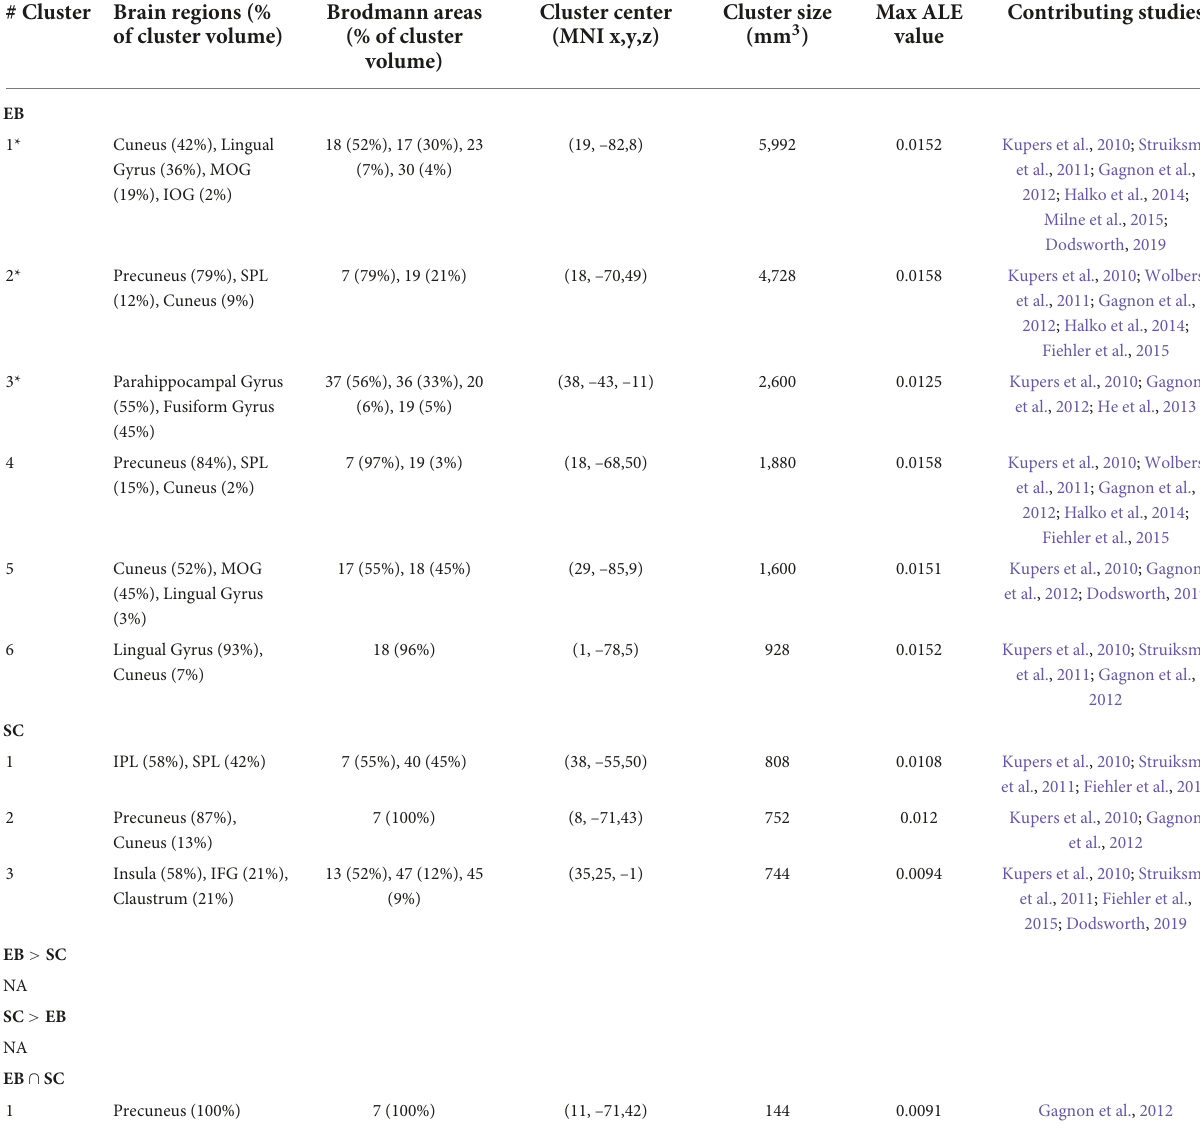
TABLE 4 Brain clusters obtained from the activation likelihood estimation (ALE) meta-analysis for spatial navigation and contributing studies. # Cluster Brain regions (% of cluster